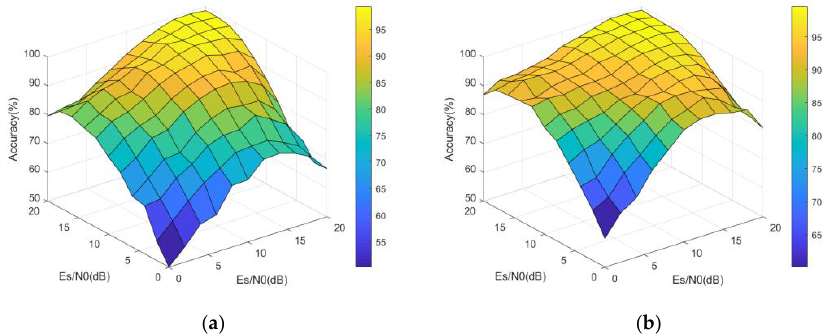
Figure 6. Overall recognition performance. ( a )